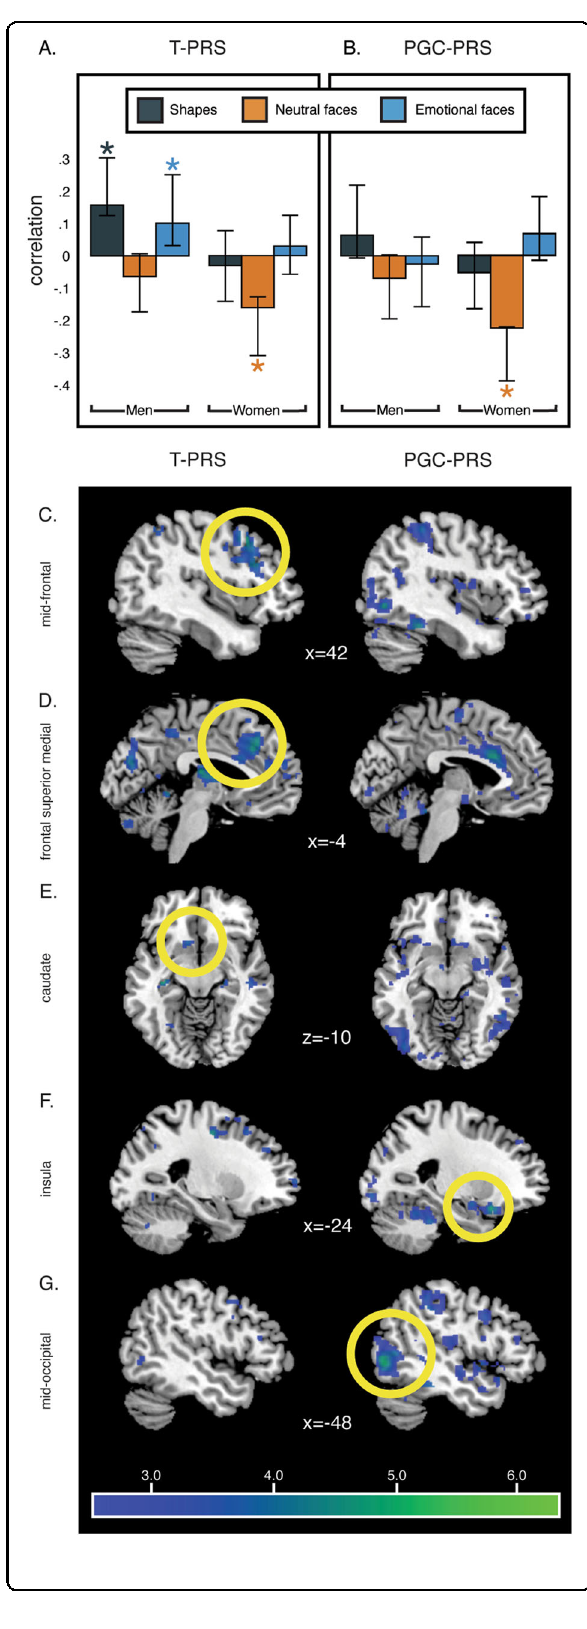
Fig. 2 Brain response to social stimuli associated with the novel T-PRS and the PGC-PRS. Higher levels of T-PRS were associated with lower activity in the LV1 clusters during the neutral faces condition in women and higher activity in the LV1 clusters during the emotional faces and shapes conditions in men ( A ). Higher levels of PGC-PRS were associated with lower activity in the LV1 clusters during the Neutral faces condition in women ( B ). Error bars represent 95% con fi dence intervals based on the bootstrapping distribution, which can be asymmetrical. Speci fi cally, higher levels of T-PRS were more strongly associated with lower activity in frontal regions, including the mid-frontal ( C ) and frontal superior medial ( D ), and caudate ( E ) and higher levels of PGC-PRS were associated with low activity in insula ( F ) and mid-occipital ( G ). These clusters survived the 2.5 bootstrap ratio (corresponding to 95% reliability) and were greater than 20